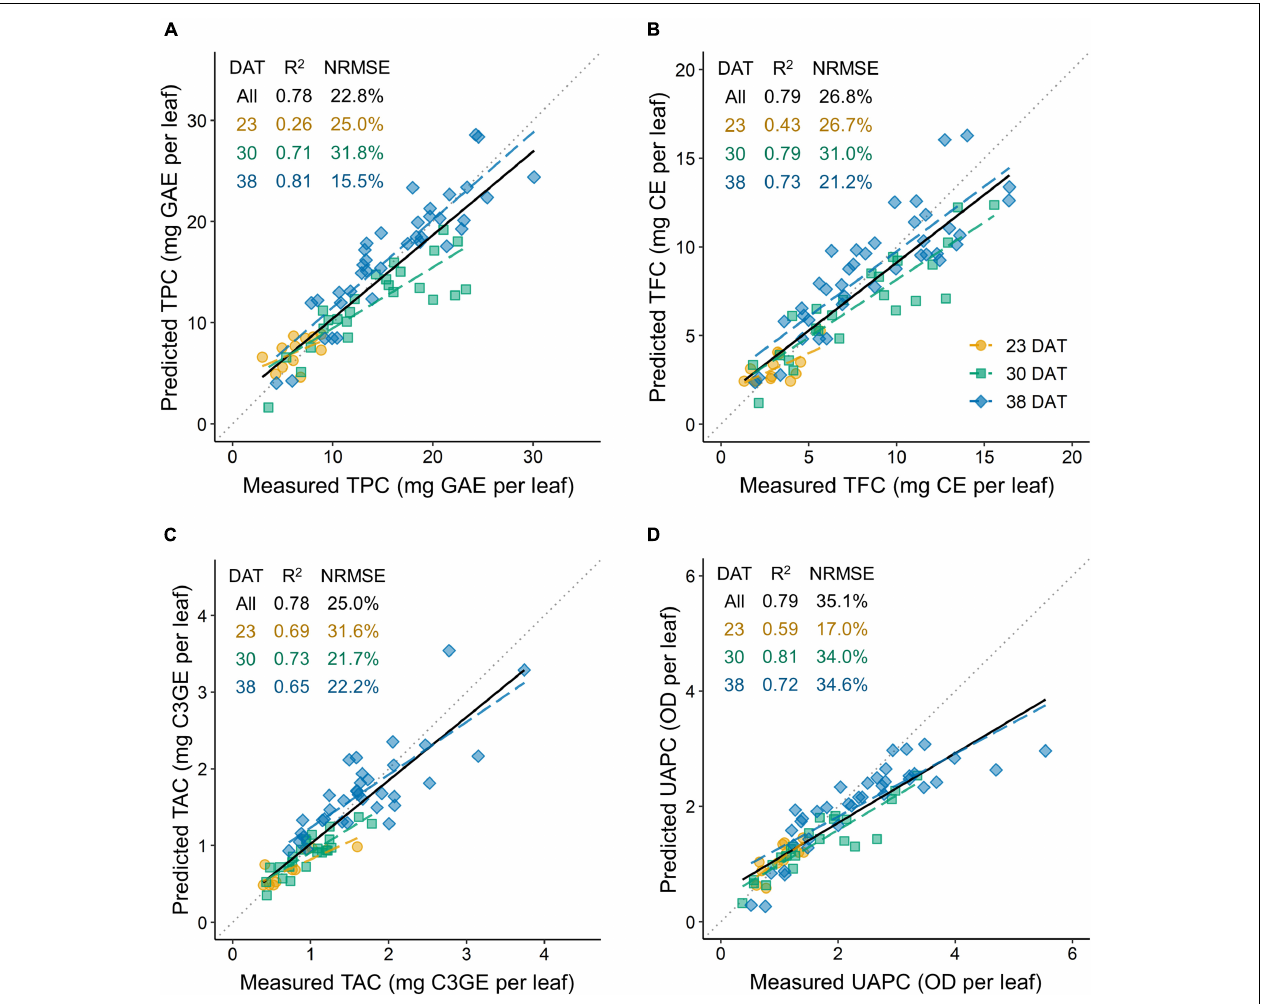
FIGURE 9 | Model accuracy for predicting phenolic content per leaf of kale plants using a test data set: TPC, total phenolic content per leaf (A) ; TFC, total flavonoid content per leaf (B) ; TAC, total anthocyanin content per leaf (C) ; and UAPC, UV-absorbing pigment content per leaf (D) . The coefficient of determination ( R 2 ) and the normalized root mean squared error (NRMSE) are presented inside each panel. The multiple regression models at 23, 30, and 38 days after transplanting (DAT) are shown in Figure 4 and Table 1 . All in DAT indicate the results in the data set across all growth stages integrated from the models at each growth